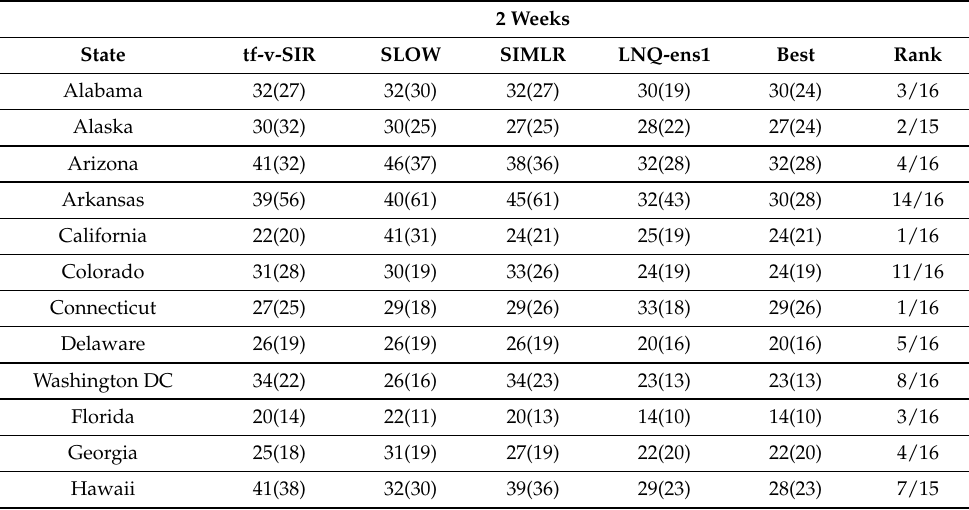
Table A2. Comparison of MAPE between different models across all the states in the US 2 weeks in advance. The number in parenthesis represents the standard deviation of the